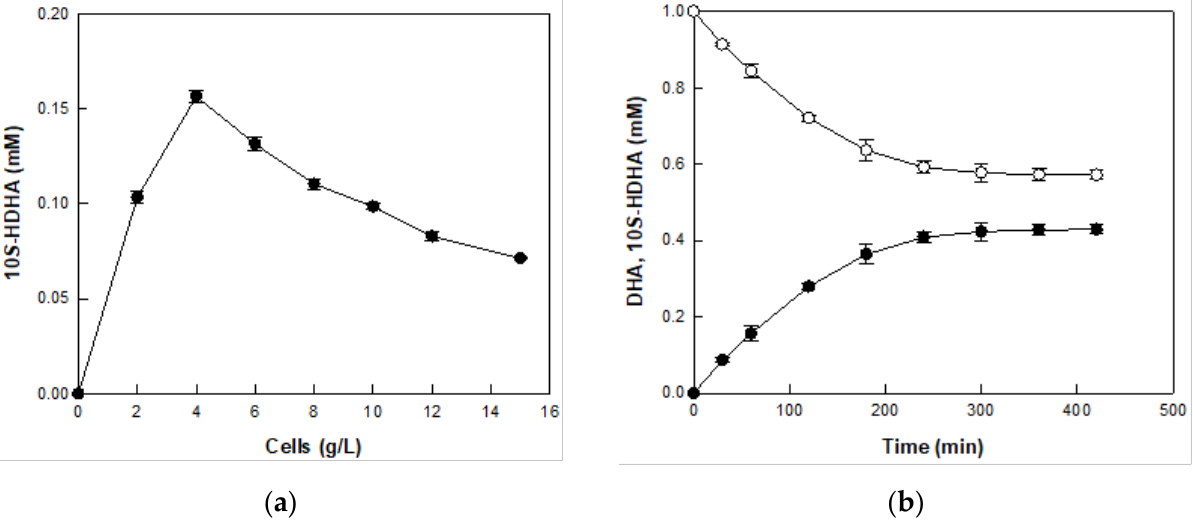
Figure 4. ( a ) Effects of cell concentration and ( b ) time-course reactions to produce 10S-HDHA (filled circle) from DHA (empty circle) in DFOH. The reactions were performed with E. coli cells expressing MO 8SLOX, substrate (DHA), and cysteine in 50 mM HEPES buffer (pH 7.5) at 35 °C for 1 h. Data represent the means of three experiments and error bars represent standard deviations.